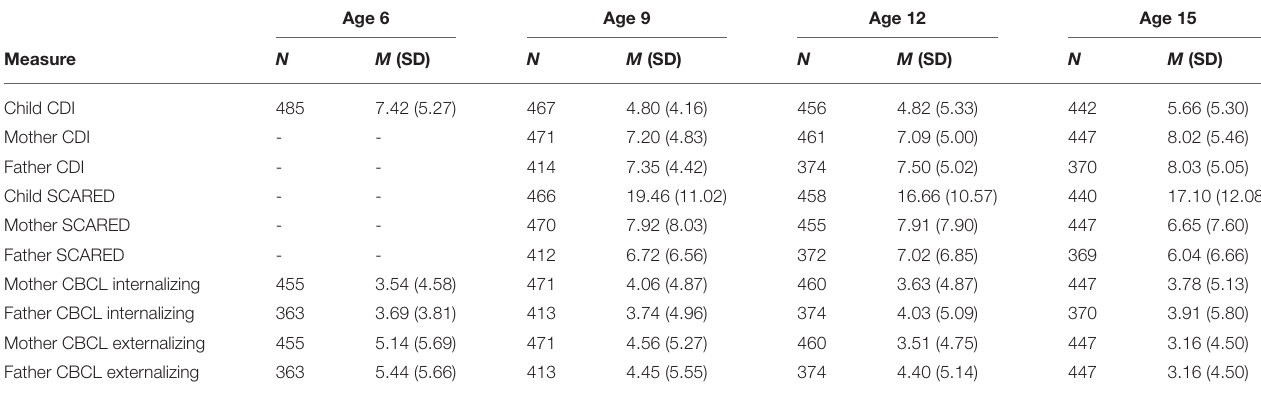
TABLE 1 | N, Means, and SDs of offspring symptom variables across assessment waves. Age 6 Age 9 Age 12 Age 15 Measure